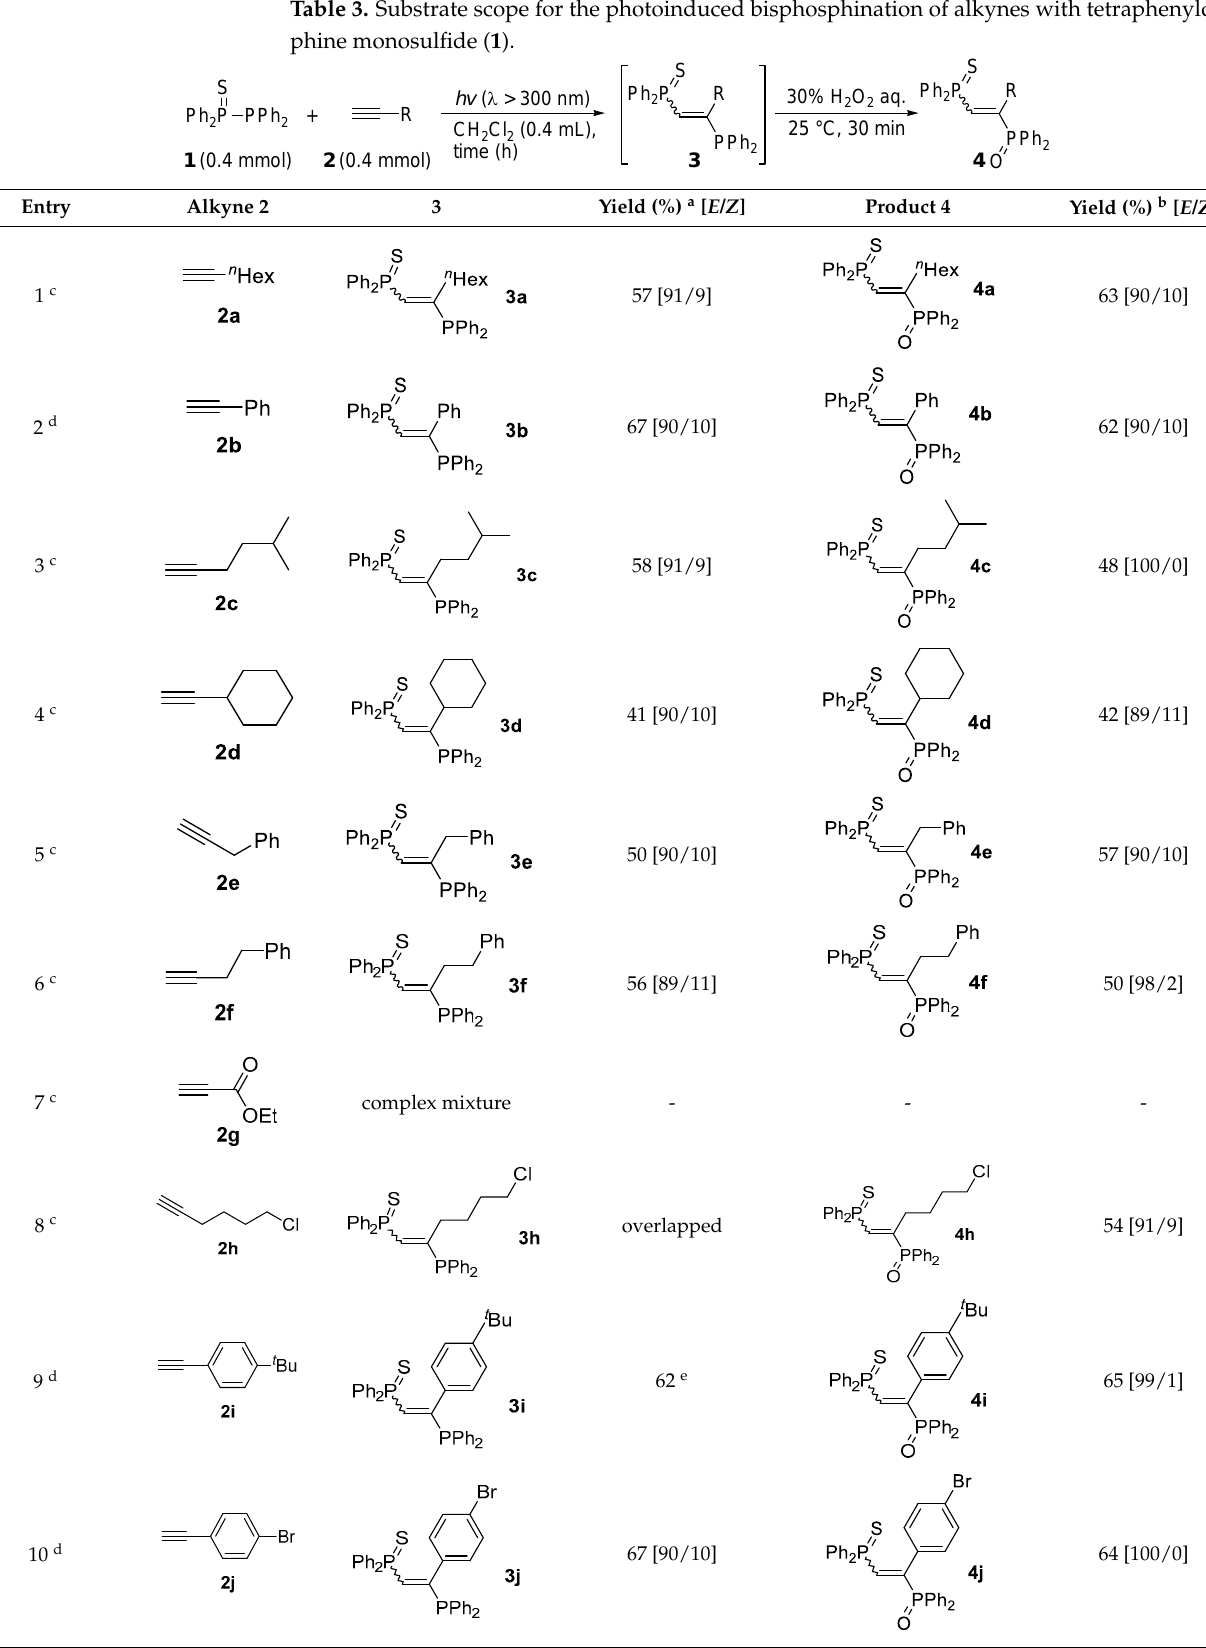
a Yields were determined by 31 P NMR spectroscopy; b isolated yields; c reaction time: 9 h; d reaction time: 2 h. e Peaks of stereoisomers in 31 P NMR